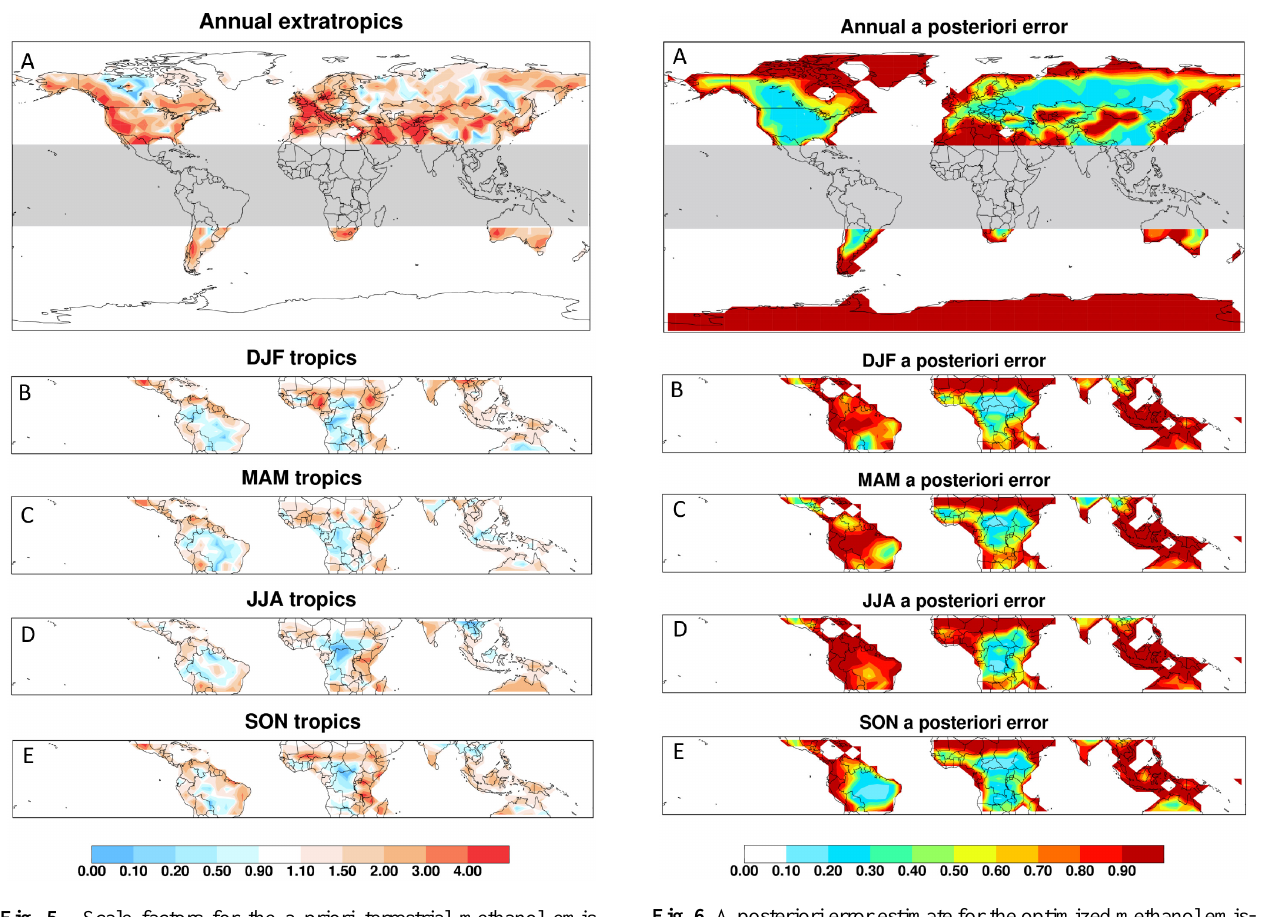
Fig. 5. Scale factors for the a priori terrestrial methanol emis- sions optimized on the basis of the TES observations. (A) Annual scale factors for the extratropics. (B) – (E) Seasonal scale factors for the tropics (DJF = December, January February; MAM = March, April, May; JJA = June, July, August; SON = September, October, November).